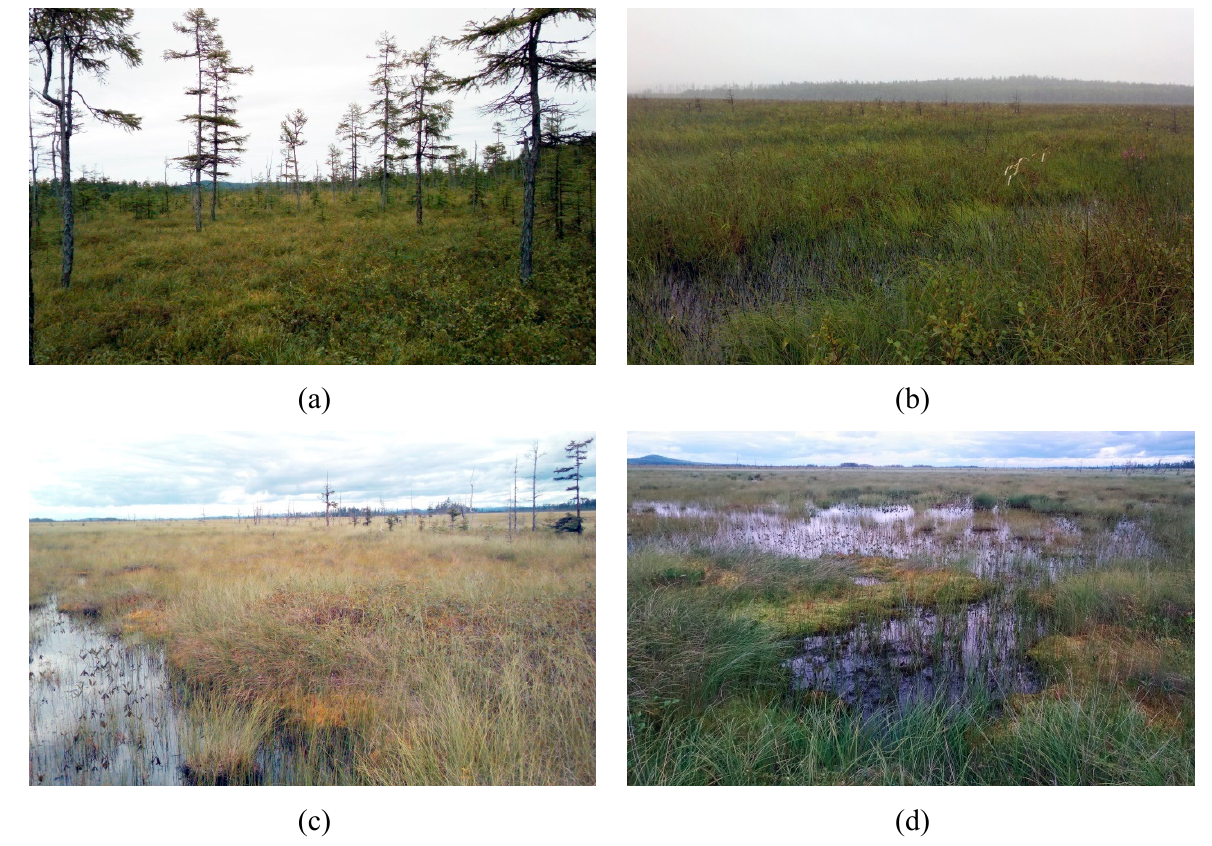
Figure 3. An overall view of the study mires: ( a ) Marginal Larix bog; ( b ) String-flark complex with narrow flarks, A1 site; ( c ) String-flark complex with wide flarks, A3 site; ( d ) Water flark, surrounded by Sphagnum papillosum lawns, A3 site.